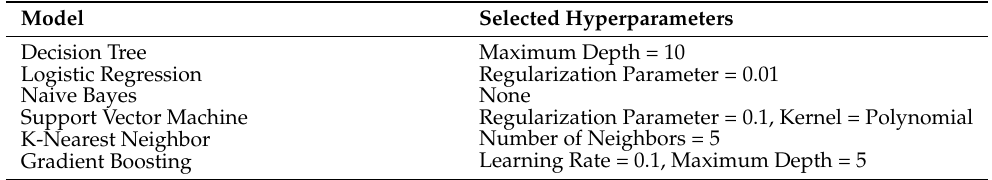
Table 4. Hyperparameters selected for each machine learning